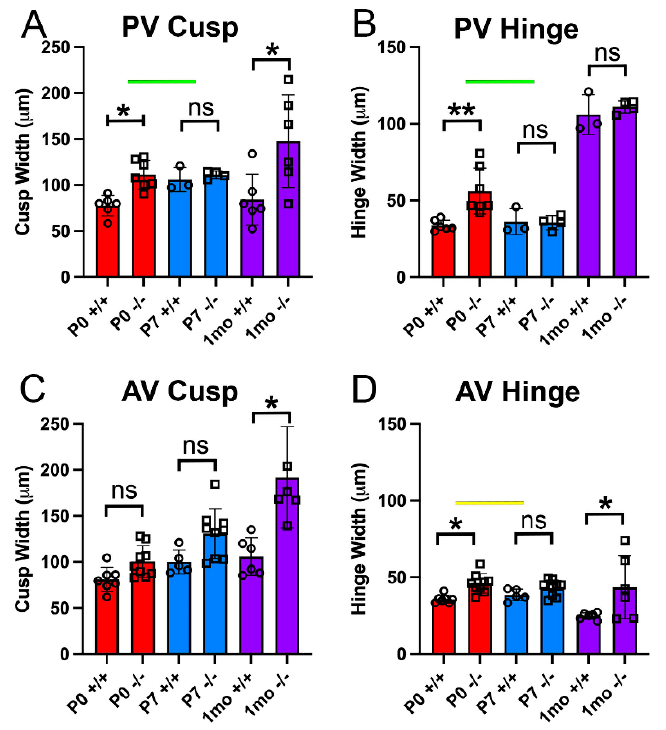
Figure 2. The widths of the Adamts5 − / − pulmonary valve cusp and hinge regions were indistinguishable from wild type at postnatal day 7, indicative of a phenotypic rescue. The thickness of the pulmonary valve (PV) cusp ( A ), PV hinge ( B ) aortic valve (AV) cusp ( C ) and AV hinge ( D ) were quantified at postnatal day 0 (P0, red), postnatal day 7 (P7, blue) and 1 month of age (1mo, purple) in the wild type (+/+) and Adamts5 − / − ( − / − ) mice. Green bars-denote the transient loss of PV Adamts5 − / − cusp phenotype ( A ) and hinge phenotype ( B ) from P0 to P7. Yellow bar—denotes the transient correction of the hinge regions of the AV. Open circles on each graph-wild type; open squares- Adamts5 − / − . *— p < 0.05; **— p < 0.01; ns—not significant. Each symbol on the graph denotes data from one mouse.